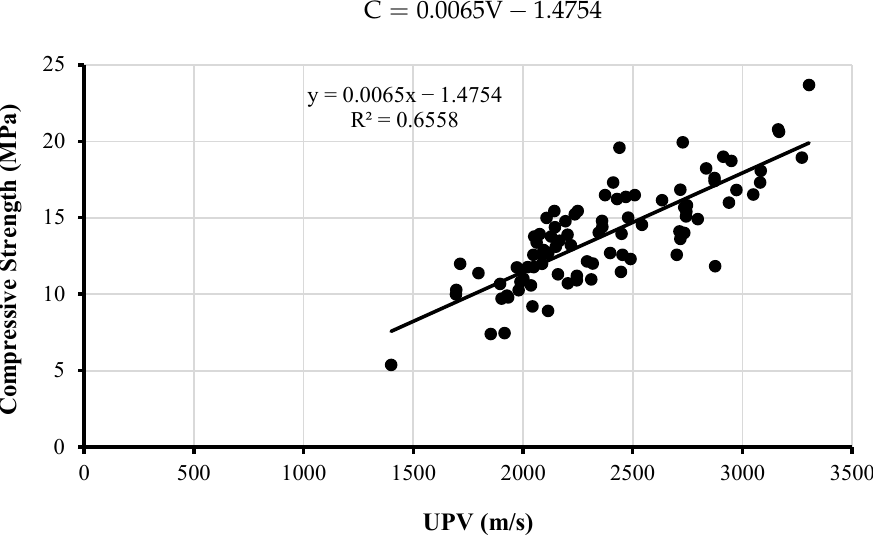
Figure 15. Compressive strength vs. UPV of all new and old bricks combined.